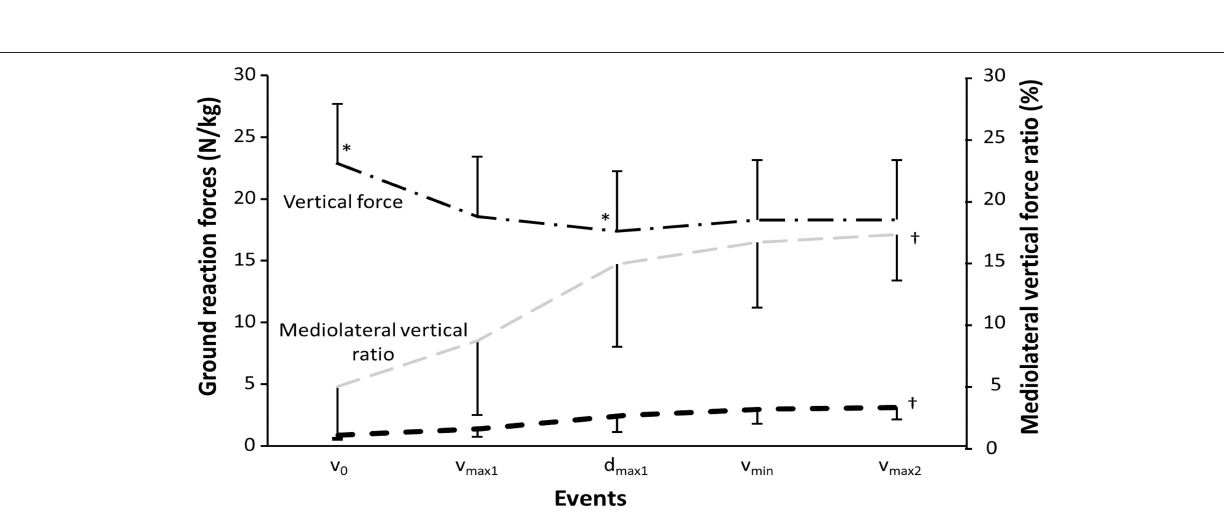
Frontiers in Sports and Active Living |